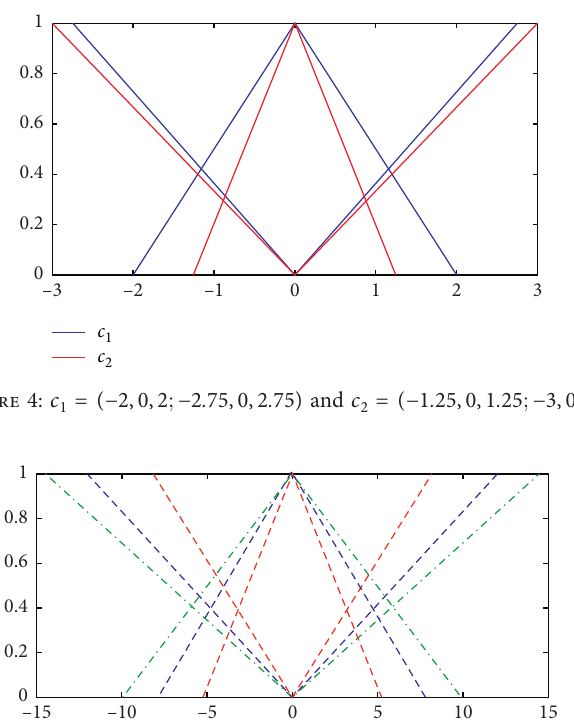
Figure 5: c � (− 2 , 0 , 2 ; − 2 . 75 , 0 , 2 . 75 ) and c 1